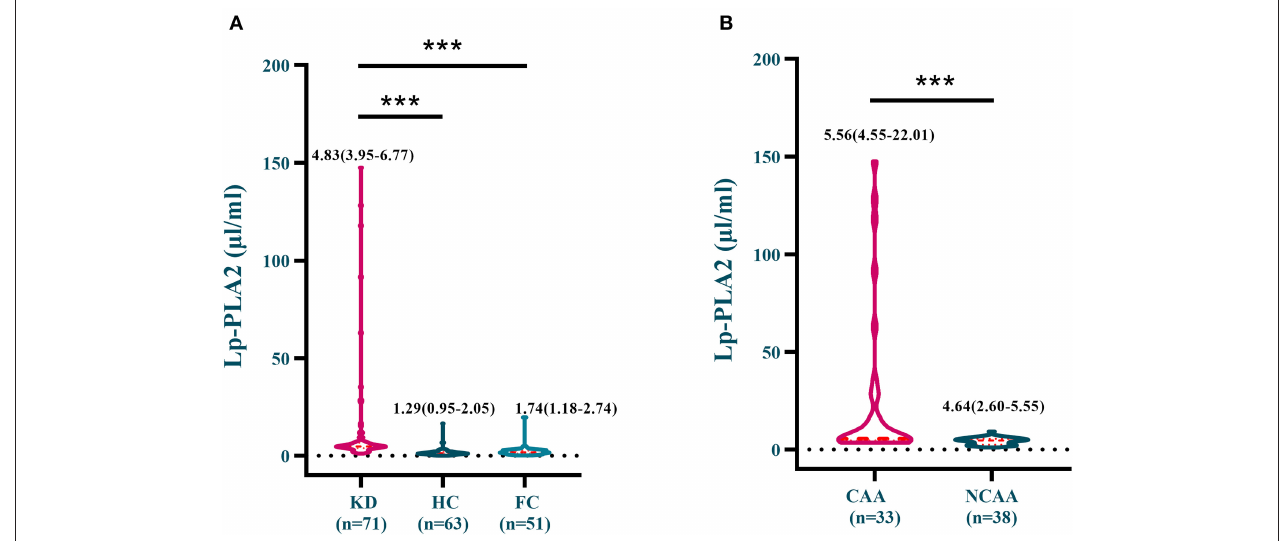
FIGURE 1 | (A) Serum Lp-PLA2 levels in the KD, the HC and the FC groups; (B) Serum Lp-PLA2 levels in the KD-CAA and the KD-NCAA groups. *** p < 0.0001.